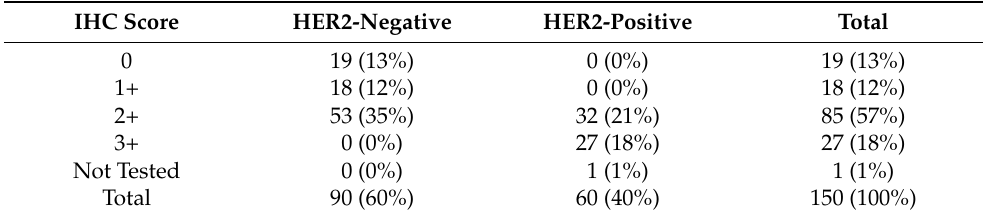
Table 2. Distribution of IHC scores and HER2 status in the test